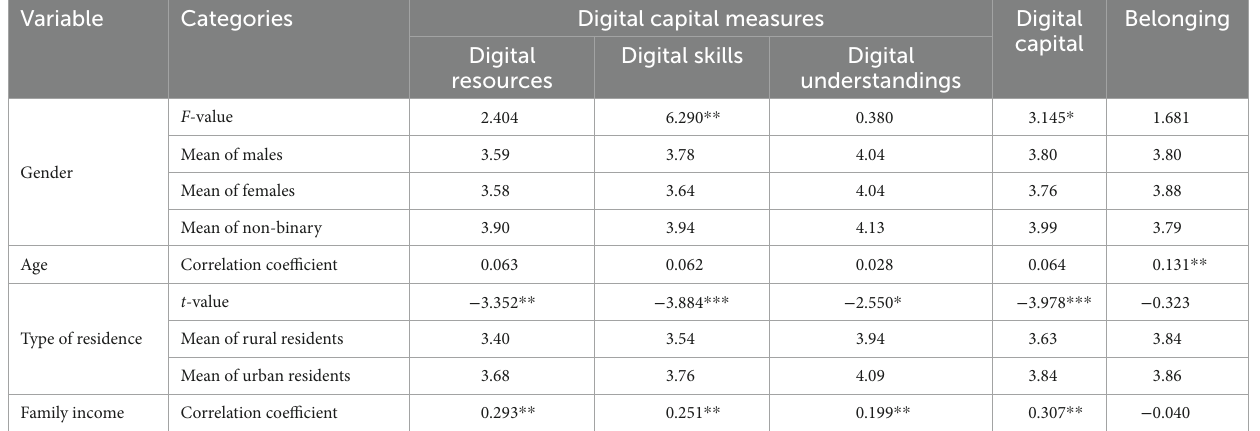
TABLE 3 Differences based on sociodemographic characteristics. Variable